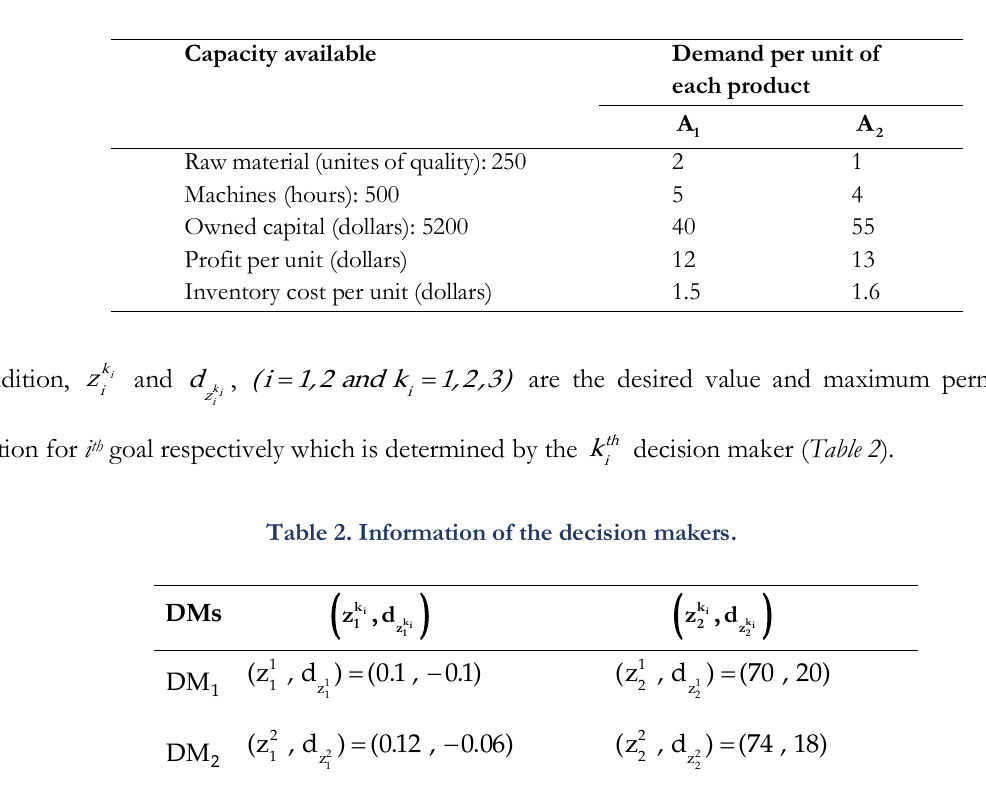
Table 1. Information for the production of the example.